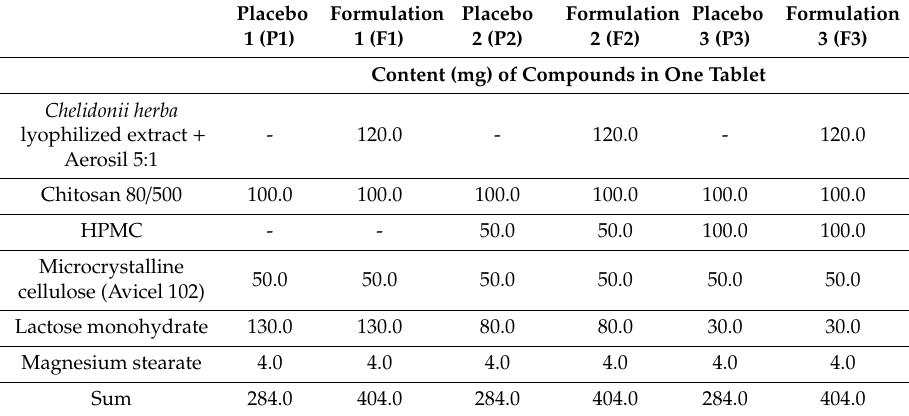
Table 1. Composition chitosan tablet formulations with Chelidonii herba lyophilized